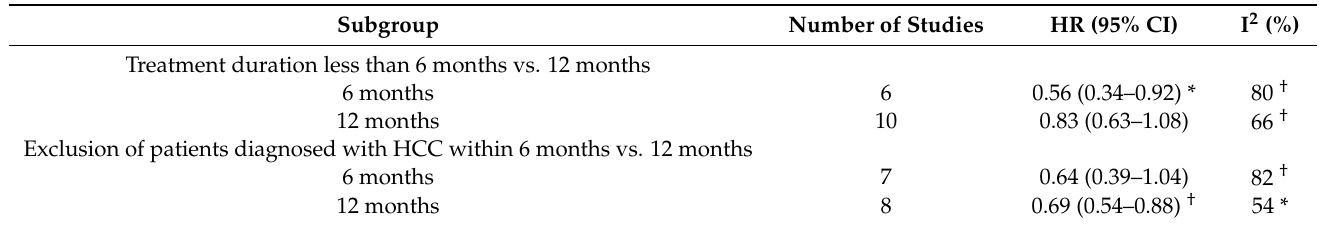
Table 3. Subgroup analysis comparing clinical outcomes based on the inclusion and exclusion criteria.